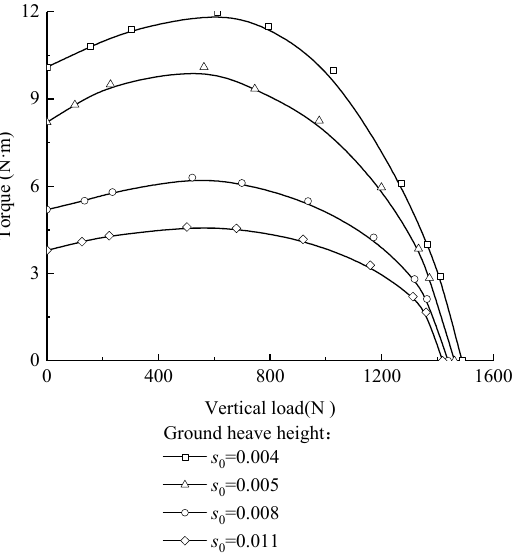
Figure 13. E ff ect of expansion ratio on the envelope of single pile bearing capacity. Figure 13. Effect of expansion ratio on the envelope of single pile bearing